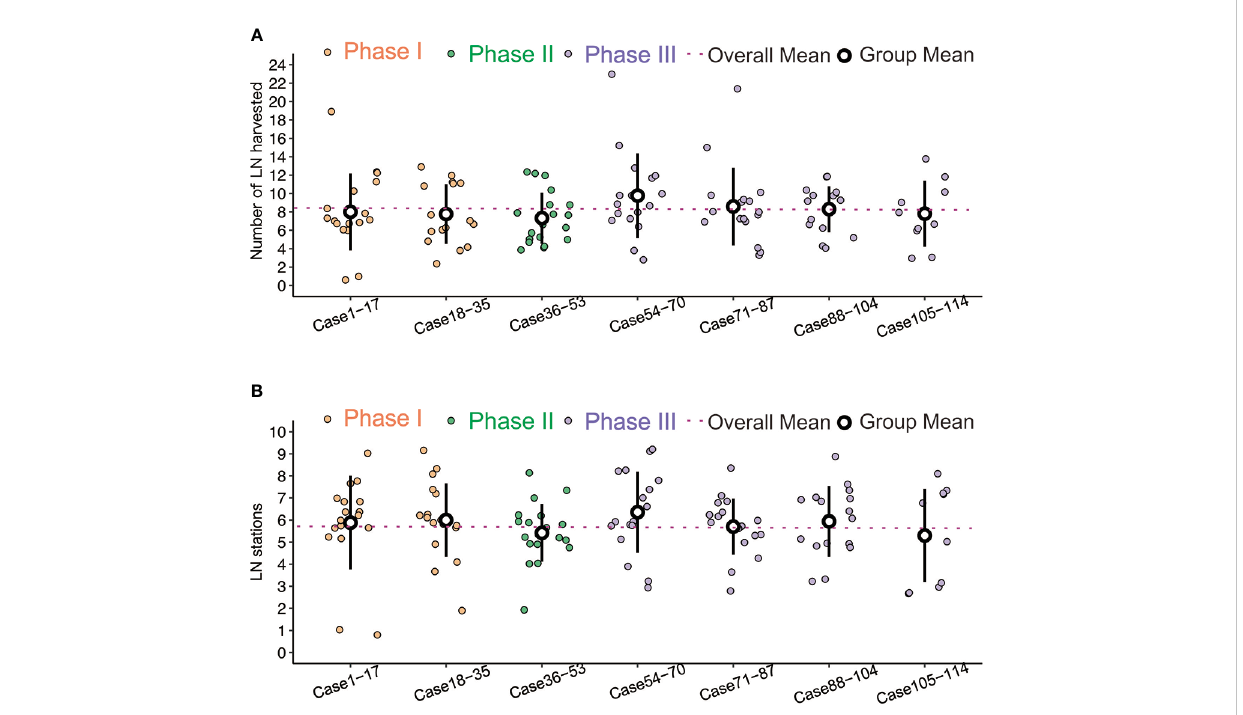
FIGURE 2 (A) Comparisons of blood loss, no signi fi cant difference between the three phases. (B) Comparisons of postoperative stay, no signi fi cant difference between the three phases.